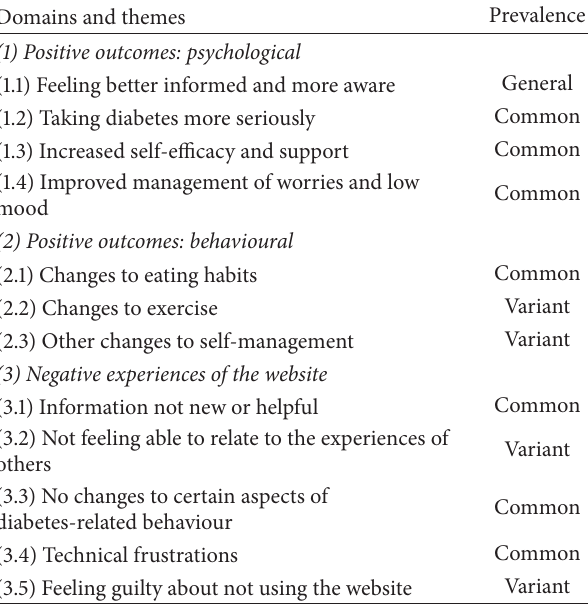
Table 6: Outline of domains and themes for postintervention inter-